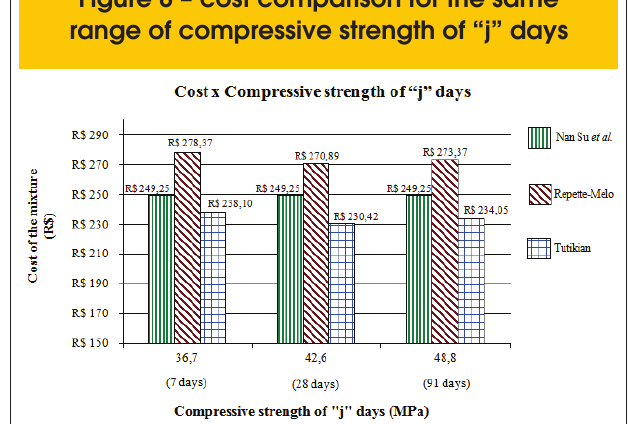
Figure 8 – cost comparison for the same range of compressive strength of “j”